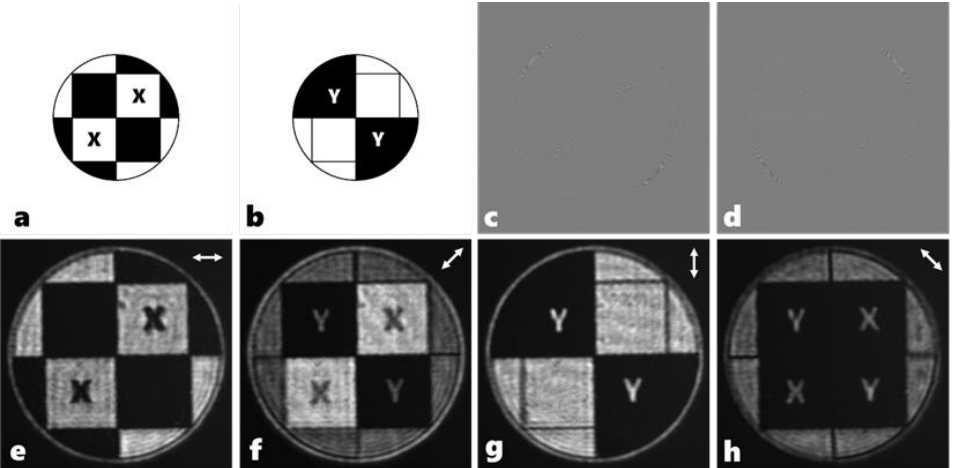
Figure 2. ( a ) and ( b ) show two binary grayscale images as functions of 𝑈 𝑥 and 𝑈 𝑦 ; ( c ) and ( d ) are their corresponding CGHs designed according to Equation (3); ( e – h ) are the light intensity distribution of different polarizer orientations. The polarization analyzer’s direction in relation to the image sensor is shown by the arrows in the sub-image’s top right corners.